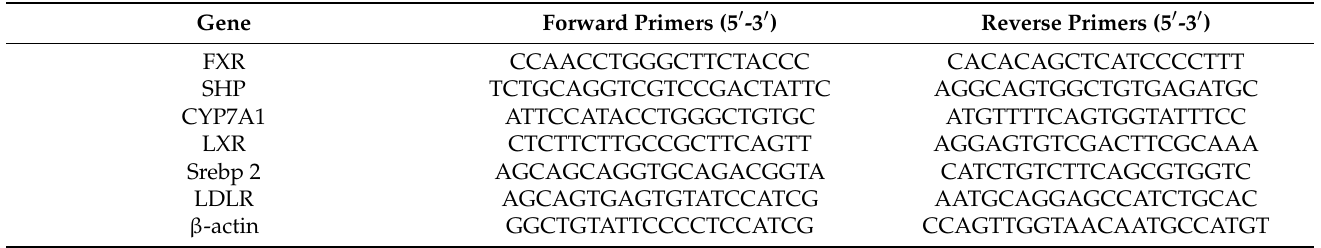
Table 4. Primer sequences used for RT-PCR in this